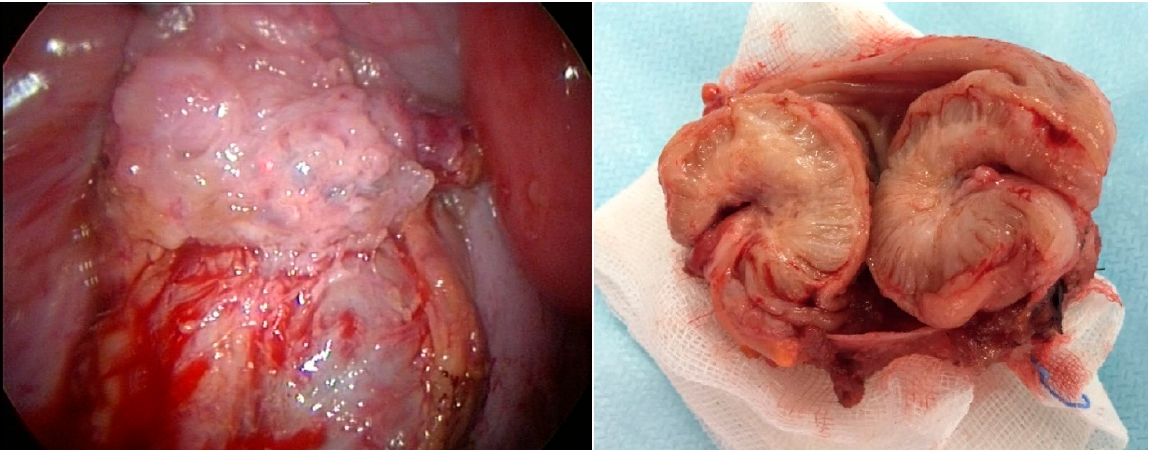
Figure 6. Images of conservative excision of short bowel resection in deep endometriosis in the bowel. Note the fibrosis around the endometriosis.